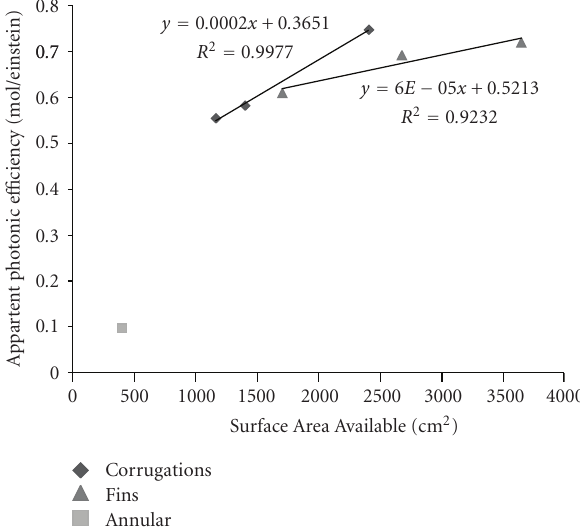
Figure 12: Apparent photonic e ffi ciency for the seven drum configurations (Co = 15 ppm, 15 rpm).